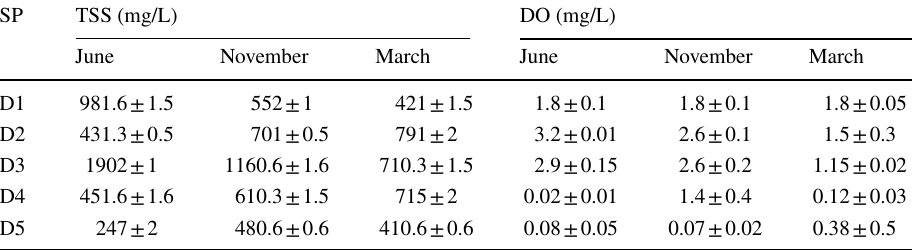
SP sampling points, D drain, A (mean ±